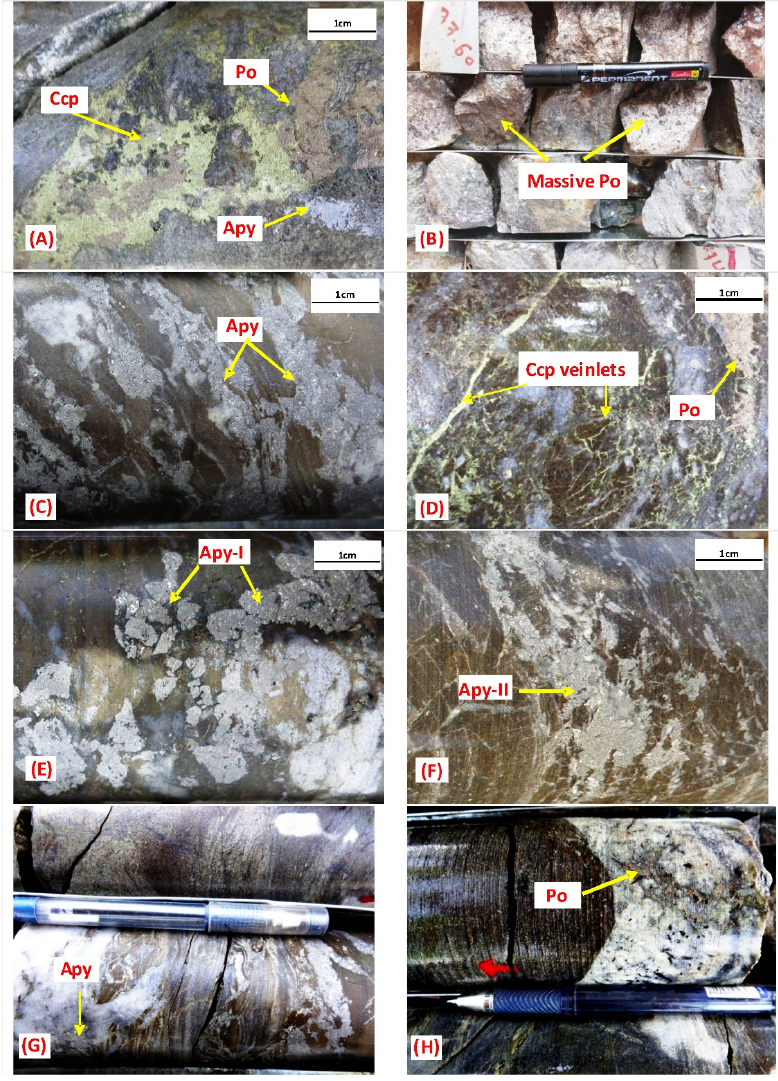
Figure 5. Photograph of drill core showing nature of sulfide mineralization in the Jagpura deposit. ( A ) Association of pyrrhotite, chalcopyrite and arsenopyrite in borehole core; ( B ) Massive to semi massive type pyrrhotite mineralization; ( C ) Foliation parallel semi massive arsenopyrite; ( D ) Vein and fracture filled chalcopyrite, pyrrhotite and arsenopyrite; ( E ) Euhedral coarse grained arsenopyrite specks of first generation; ( F ) Fine grained massive arsenopyrite of second generation; ( G ) Sec- ond generation arsenopyrite in quartz vein; ( H ) Stringers of pyrrhotite and disseminations of arse- nopyrite in pegmatite vein. (Apy = arsenopyrite, Po = pyrrhotite, Ccp = chalcopyrite).